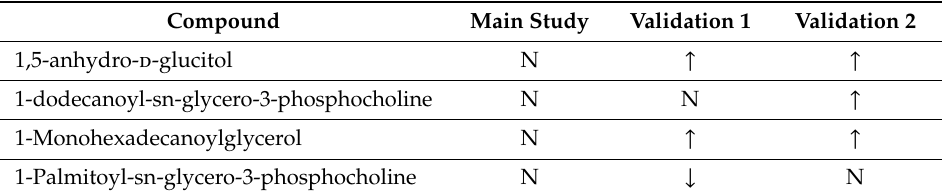
Table 5. Metabolites identified in the main study and validation studies 1 and 2 together with the combined loading vectors from these